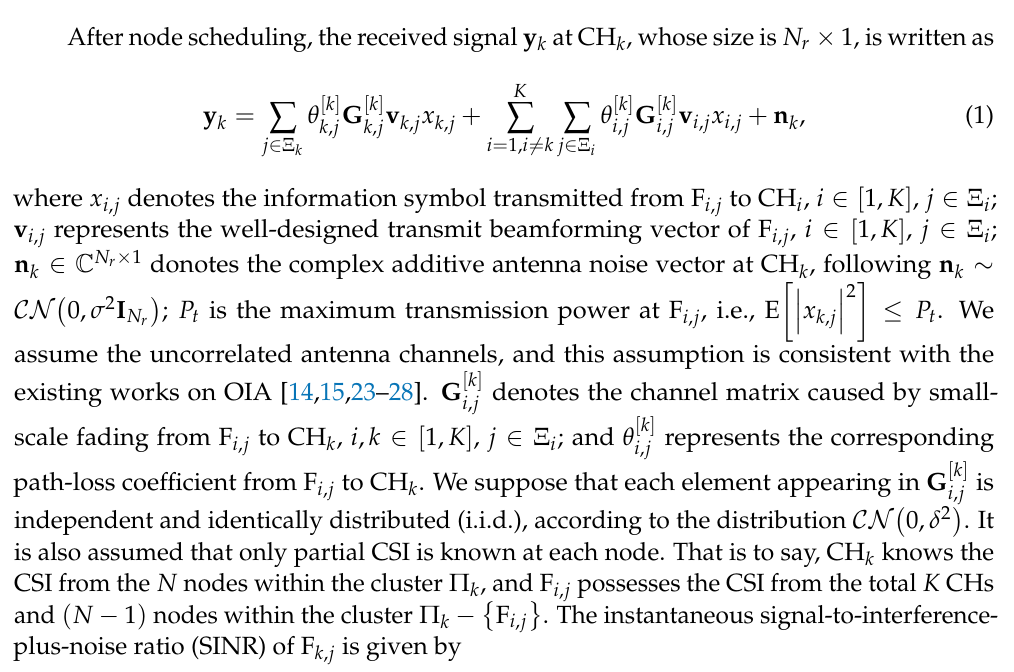
Figure 1. System model for K -cluster SWIPT-enabled sensor network. In each cluster, S nodes are selected from N nodes to send data streams to its corresponding CH, and the remaining ( N − S ) nodes can conduct wireless EH to recharge their